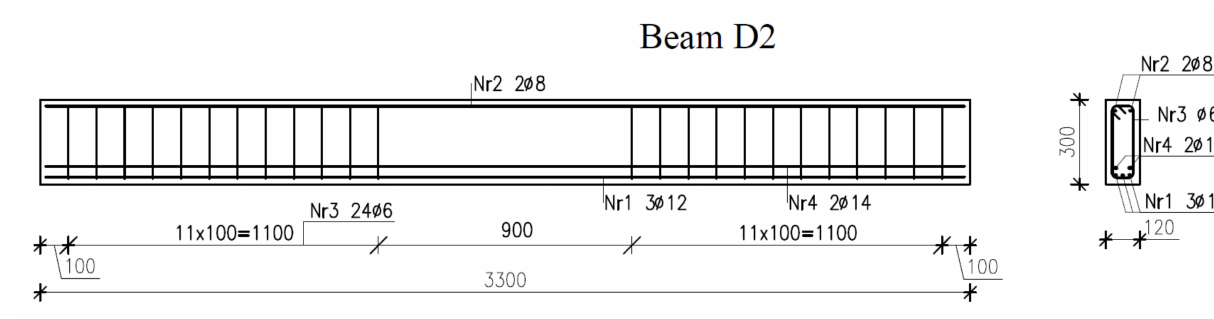
Figure 2. Reinforcement in beams A2.